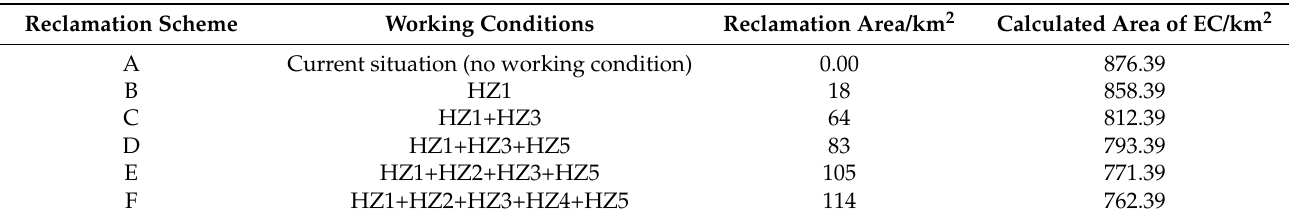
Table 18. Changes in marine area of Haizhou Bay (scenario